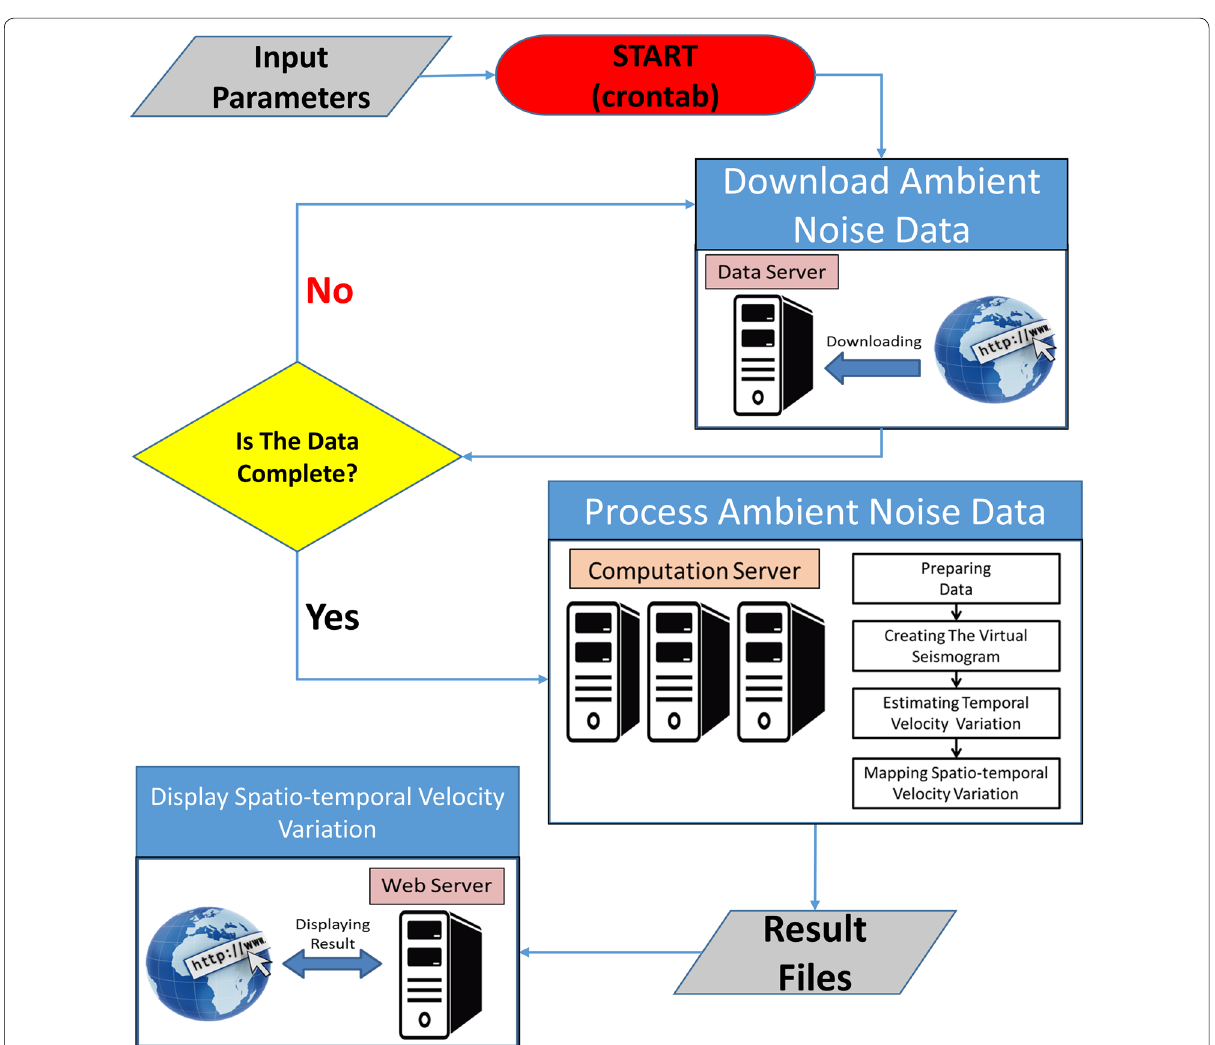
Fig. 10 Schematic diagram of the ambient-noise monitoring system. The system comprises three operations: downloading ambient-noise data, processing the data, and displaying the spatio-temporal velocity variations on a website. A crontab module starts the update cycle every day at midnight. Presently we update the monitoring results every week on the website